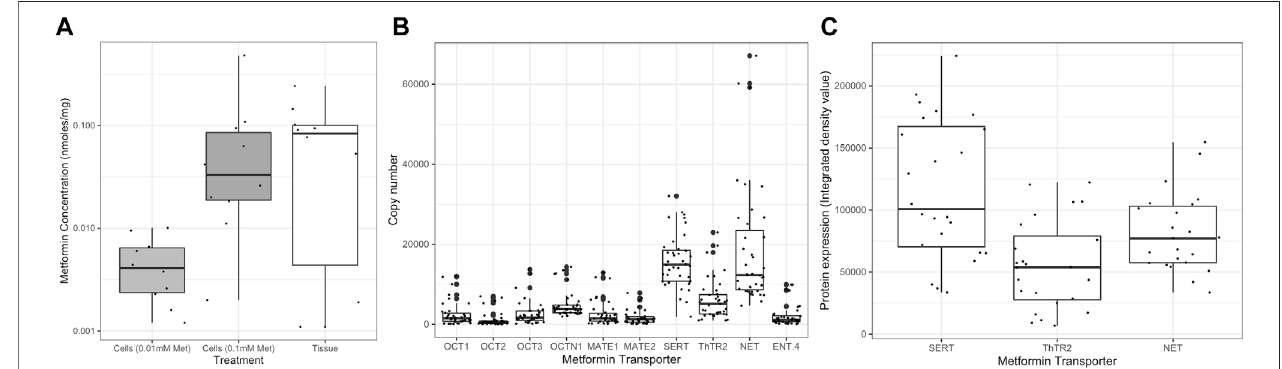
FIGURE 2 | (A) Metformin concentration in trophoblasts treated in vitro with: (0.01mM and 0.1 mM) and placental tissue exposed in vivo . There was a non- signi fi cant difference between tissue metformin concentrations and metformin concentrations in 0.01 mM-treated cells ( p = 0.08). There was no signi fi cant difference between tissue metformin concentrations and metformin concentrations in 0.1 mM-treated cells ( p = 0.894). Metformin concentration is plotted on a log10 scale. Individual data points each represent a single trophoblast sample with points more than 1.5x IQR highlighted with larger dots. Light grey boxes: trophoblasts treated with 0.01 mM metformin; Dark grey boxes: 0.1 mM metformin; white boxes: Placental tissue from patients treated with metformin in vivo . (B) mRNA level of potential metformin transporters in trophoblasts ( n = 30 samples). Genes assayed: OCT-1 (SLC22A1), OCT-2 (SLC22A2), OCT-3 (SLC22A3), MATE-1 (SLC47A1), MATE-2 (SLC47A2), SERT (SLC6A4), ThTR2 (SLC19A3), NET (SLC6A2) and ENT-4 (SLC29A4). All copy numbers expressed relative to genomic DNA standard curve runoneveryplate. (C) RelativeproteinlevelsofSERT(SLC6A4),ThTR2(SLC19A3),NET(SLC6A2)[Allproteinswerepresentatdensitiessigni fi cantlyabovebackground ( p <